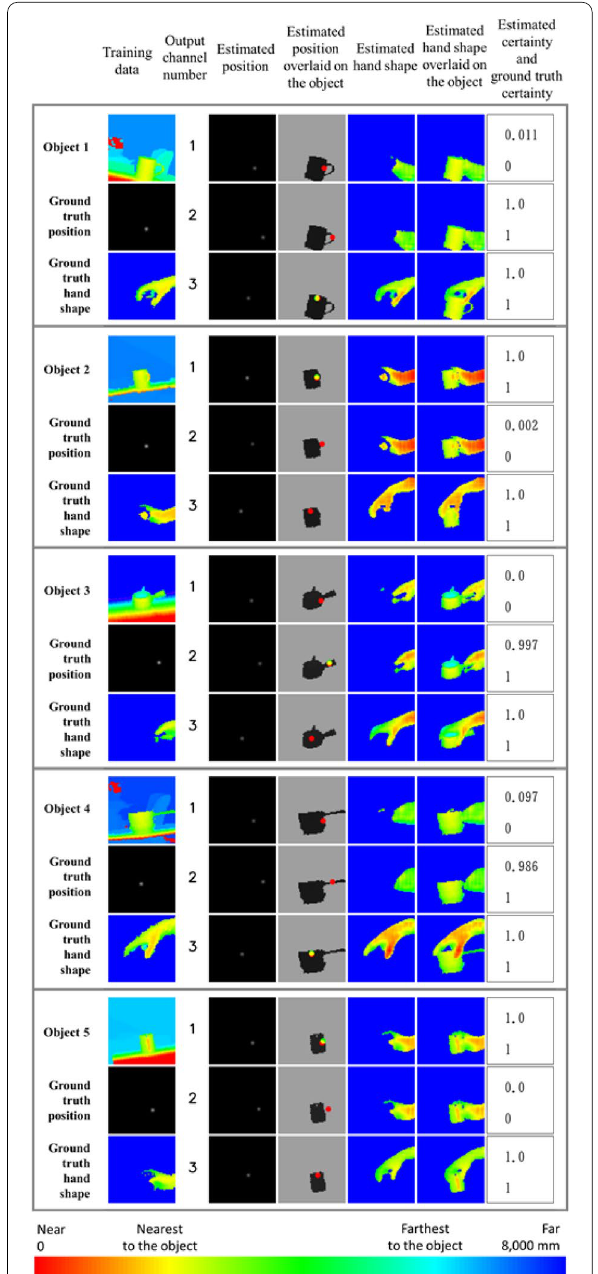
Fig. 10 Results of recalling the grasping method with certainty for the training data. Each row in the second to rightmost columns corresponds to each typical grasping type that is clustered in the grasping position network. The third column displays the estimated grasping position and the ground truth in red and green, and the intersection pixels in yellow. The ground truth is displayed only on the image of the channel that is selected in Eq. (2). The pixel color of the object and the hand shape images encodes the depth values by the “red(near)-blur(far)” colormap